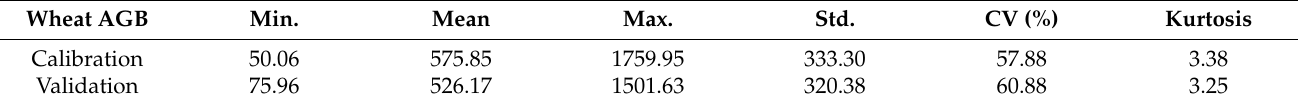
Table 2. Descriptive statistics for winter wheat AGB (g/m 2 ) of calibration and validation datasets. Wheat AGB Min. Mean Max. Std. CV (%) Kurtosis